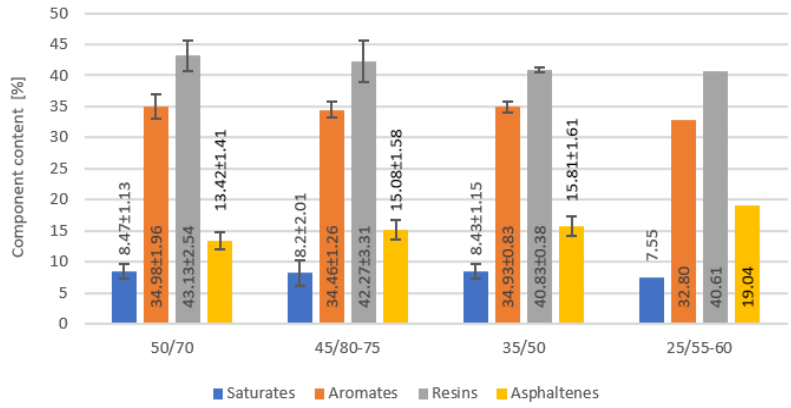
Figure 3. Fractional composition (SARA analysis) of tested bitumen samples.